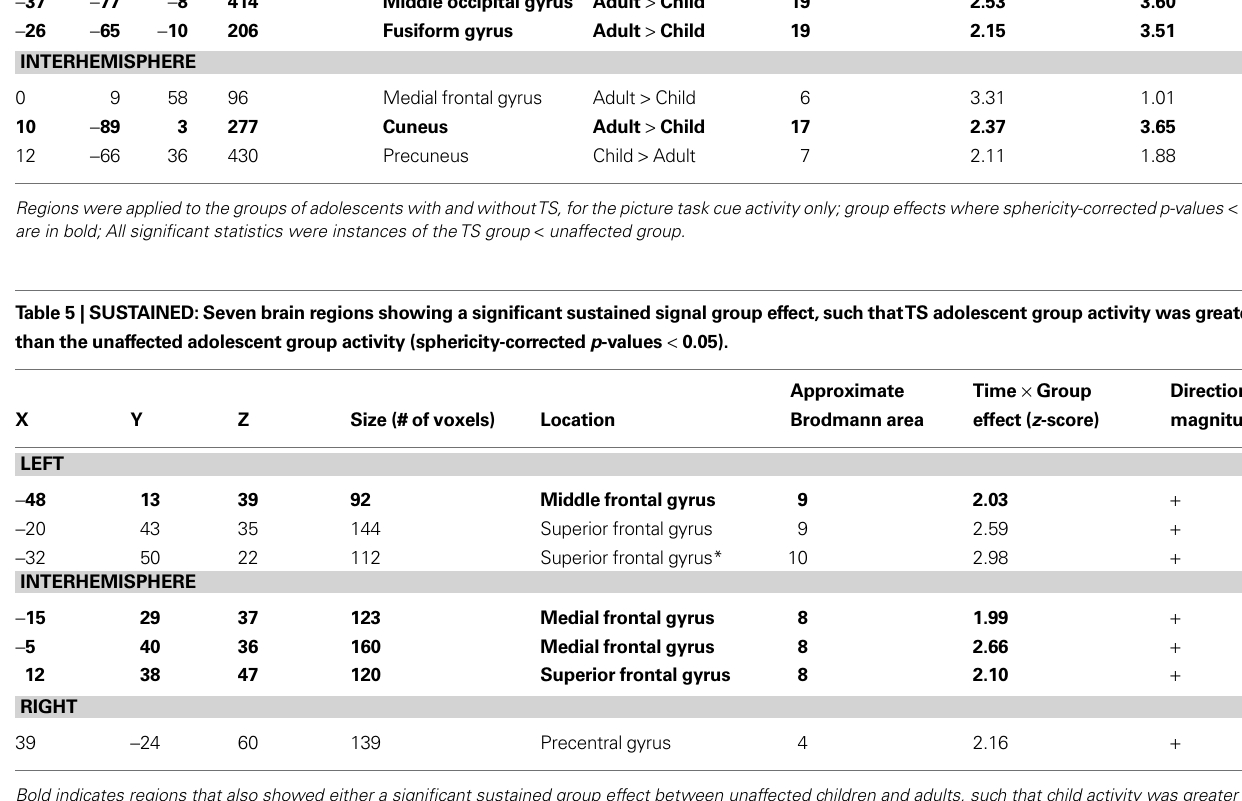
Bold indicates regions that also showed either a signifi cant sustained group effect between unaffected children and adults, such that child activity was greater than adult activity, or signifi cant activity for children only (not adults) (sphericity-corrected p-values < 0.05). Asterisks indicate regions that overlap with regions from the two putative control networks.